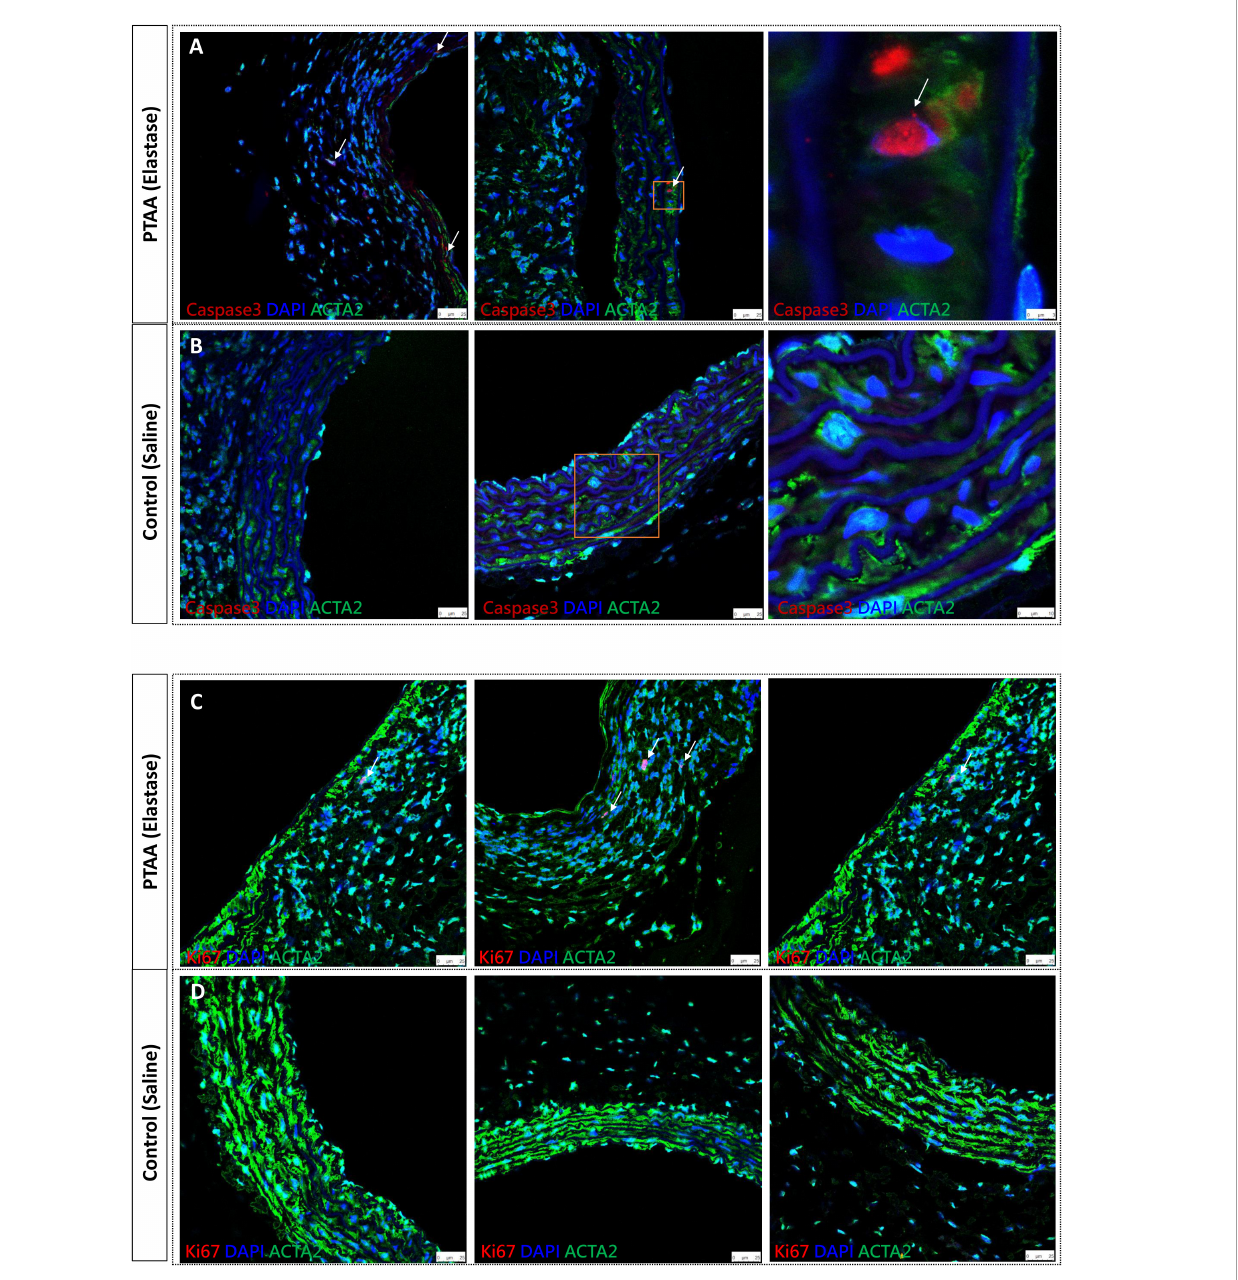
FIGURE4 Activated caspase 3 and Ki67 immunofluorescence staining of proximal thoracic aortic aneurysms (PTAAs). (A) Representative immunofluorescence images of activated caspase 3 (Red), ACTA2 (Green) and nuclear (DAPI, Blue) in the PTAA sections and (B) in the control aortas. White arrows indicate the caspase 3 positive smooth muscle cells (SMCs). (C) Representative immunofluorescence images of Ki67 (Red), ACTA2 (Green) and nuclear (DAPI, Blue) in the PTAA sections and (D) in the control aortas. White arrows indicate the Ki67 positive